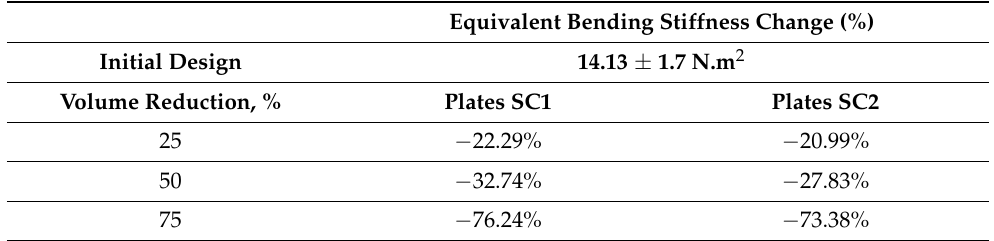
Table 2. The equivalent bending stiffness change percentage in comparison to INT-BP